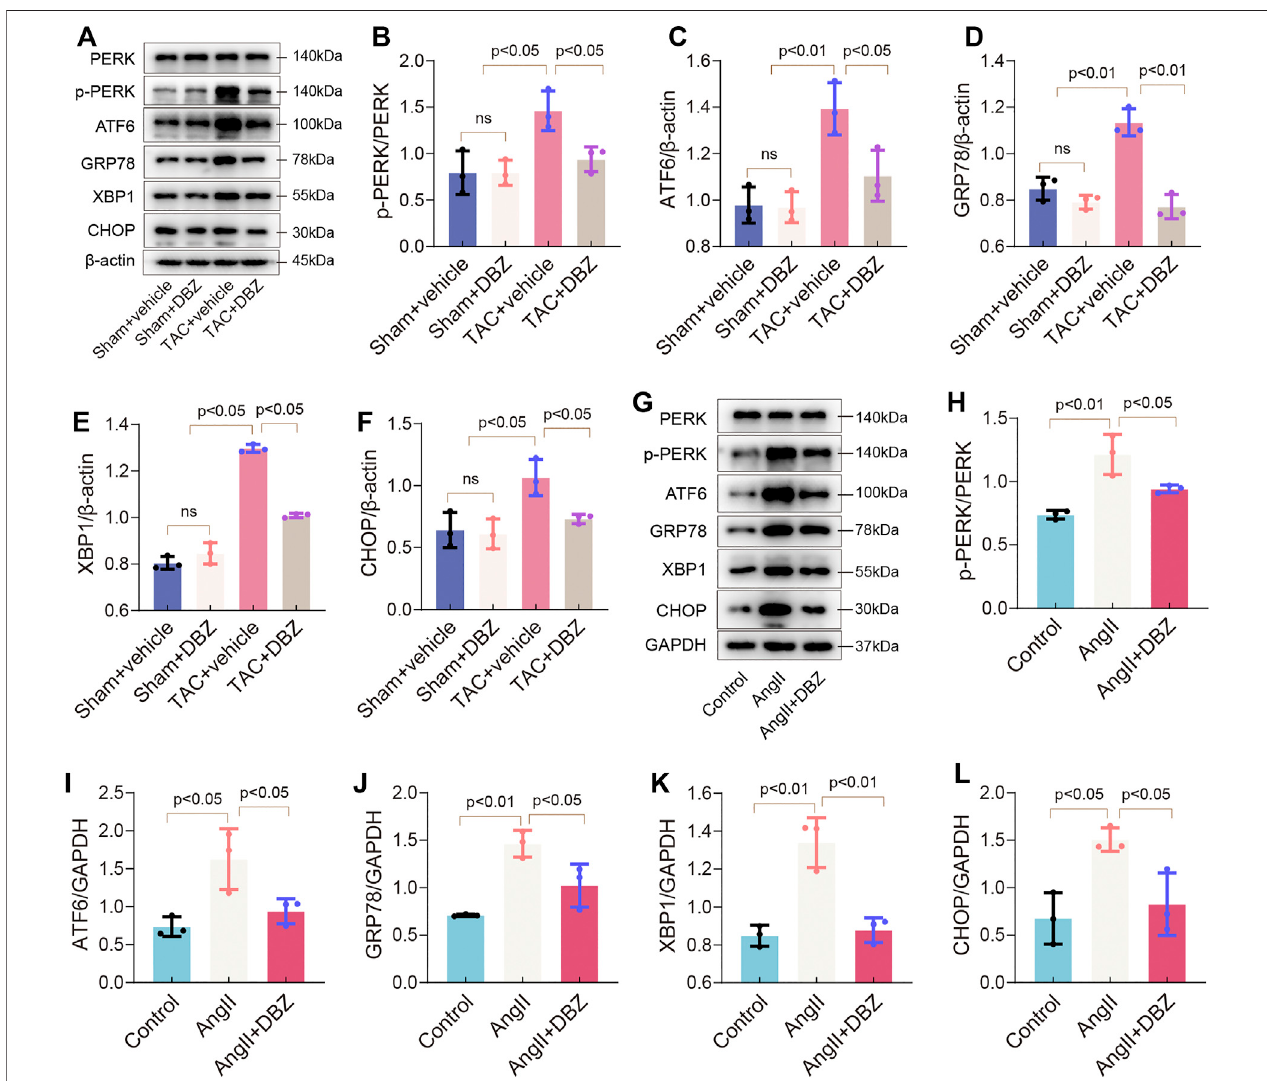
FIGURE 4 | DBZ attenuated ER stress. (A – F) Protein levels of PERK, p-PERK, GRP78, ATF6, CHOP, XBP1 were determined by Western blotting assay and quanti fi ed by densitometry. n = 3. (G – L) Protein levels of PERK, p-PERK, GRP78, ATF6, CHOP, XBP1 were determined by Western blotting assay and quanti fi ed by densitometry. n = 3. Results are expressed as means ± SD. Statistical analyses were performed by one-way ANOVA followed by Bonferroni ’ s post-hoc test.